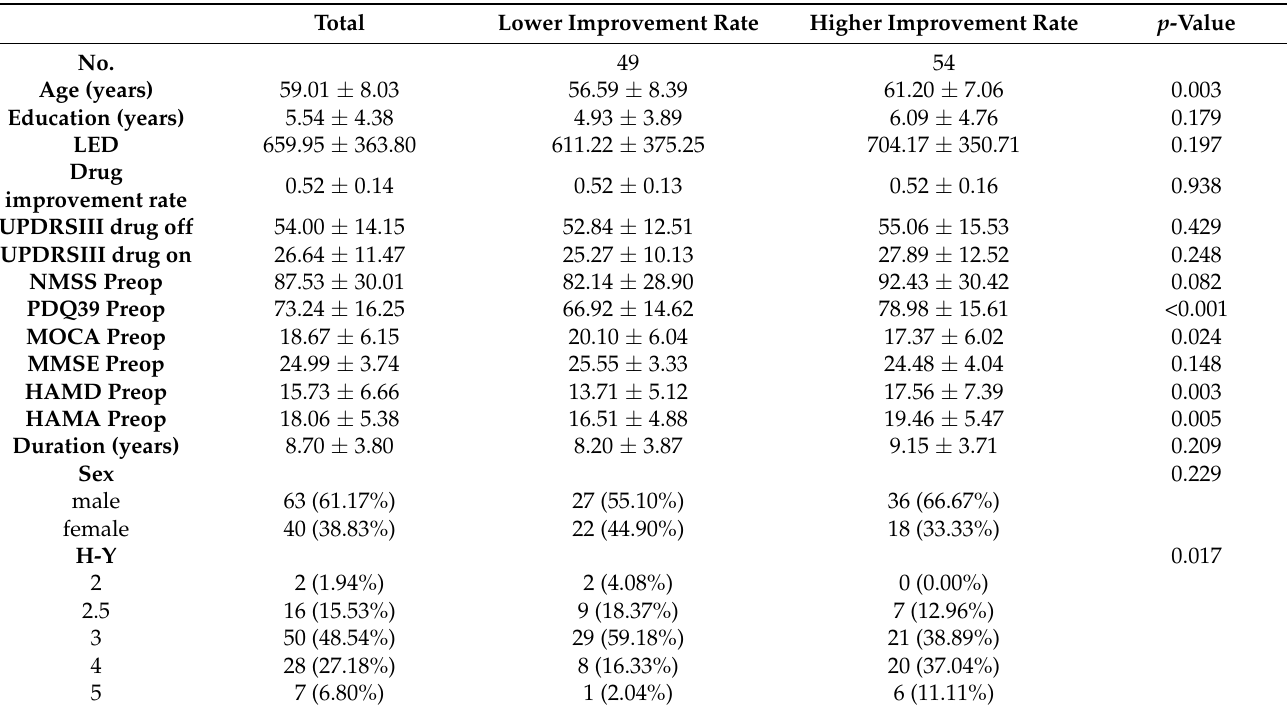
Table A1. Clinical data of all patients and comparison between patients with higher improvement rate of depression and those with lower rate of